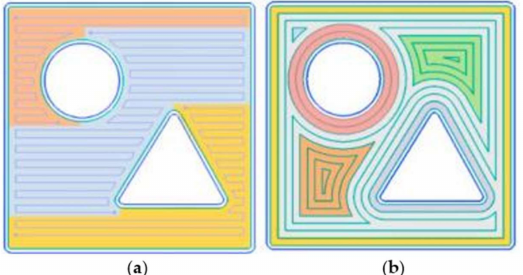
Figure 3. Comparison of di ff erent tool-path generation strategies; ( a ) direction parallel path, ( b ) contour parallel path,